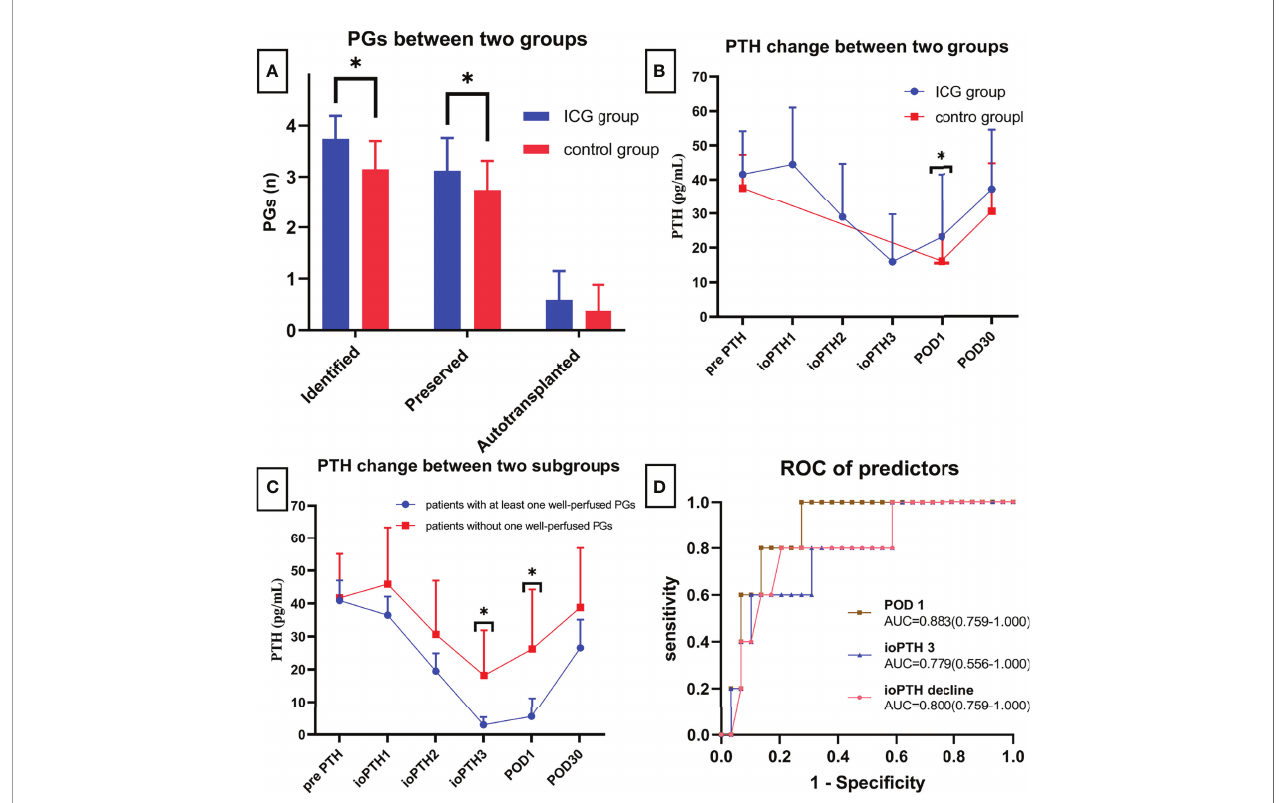
FIGURE 4 | (A) Comparison of identi fi ed, preserved and autotransplanted PGs between two groups; (B) PTH changes between two groups; (C) PTH changes between patients with at least one well vascularized PG and patients without; (D) ROC of different predictors for postoperative hypocalcemia. * means statistically signi fi